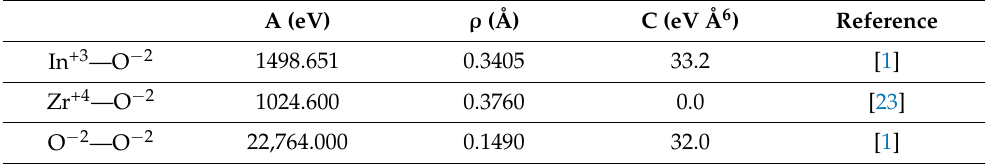
Table 1. Buckingham interatomic pair potential parameters for the In 2 O 3 and ZrO 2 physical